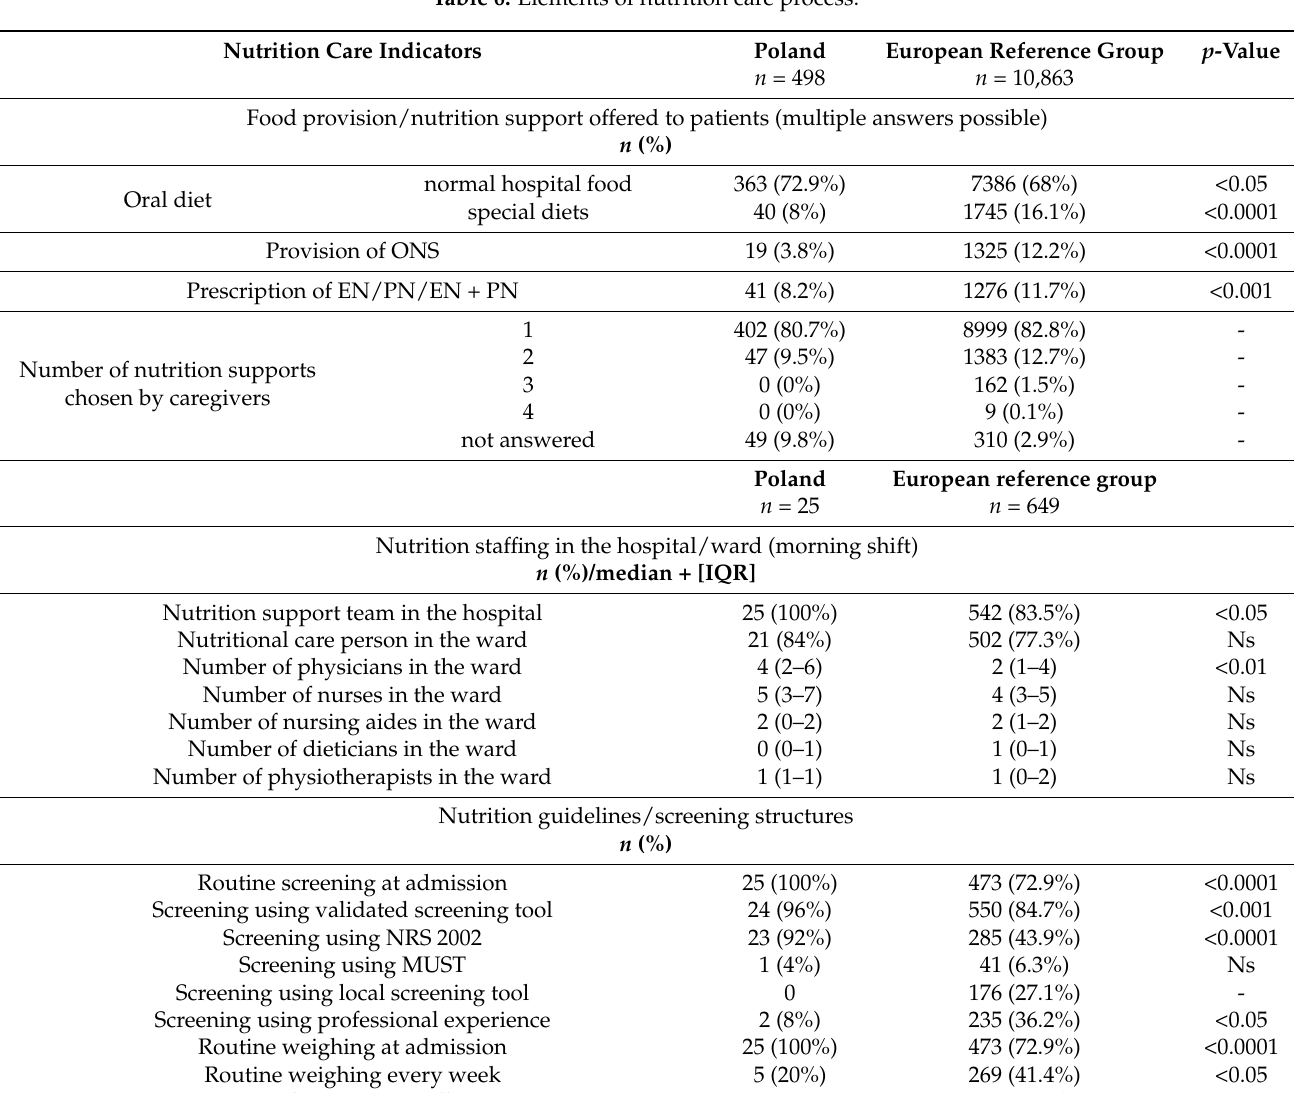
Figure 2. Prevalence of malnutrition in percentage. Abbreviations: Alt. 1, Alternative 1; Alt. 2, Alternative 2. Table 6. Elements of nutrition care